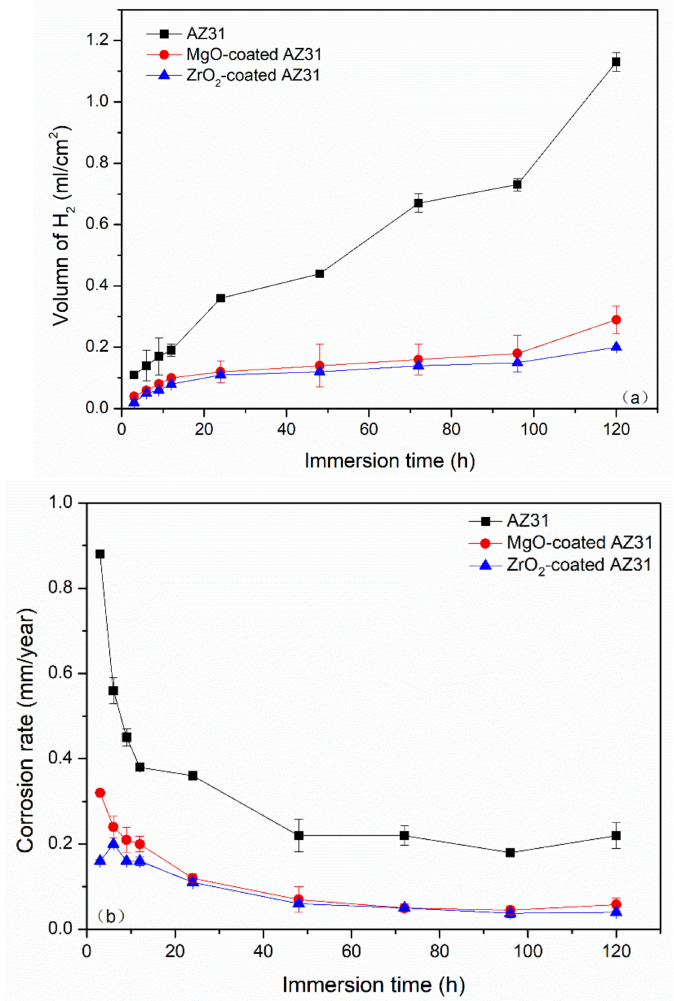
Figure 9. ( a ) Hydrogen evolution data for specimens immersed for 5 days in SBF, and ( b ) corresponding corrosion